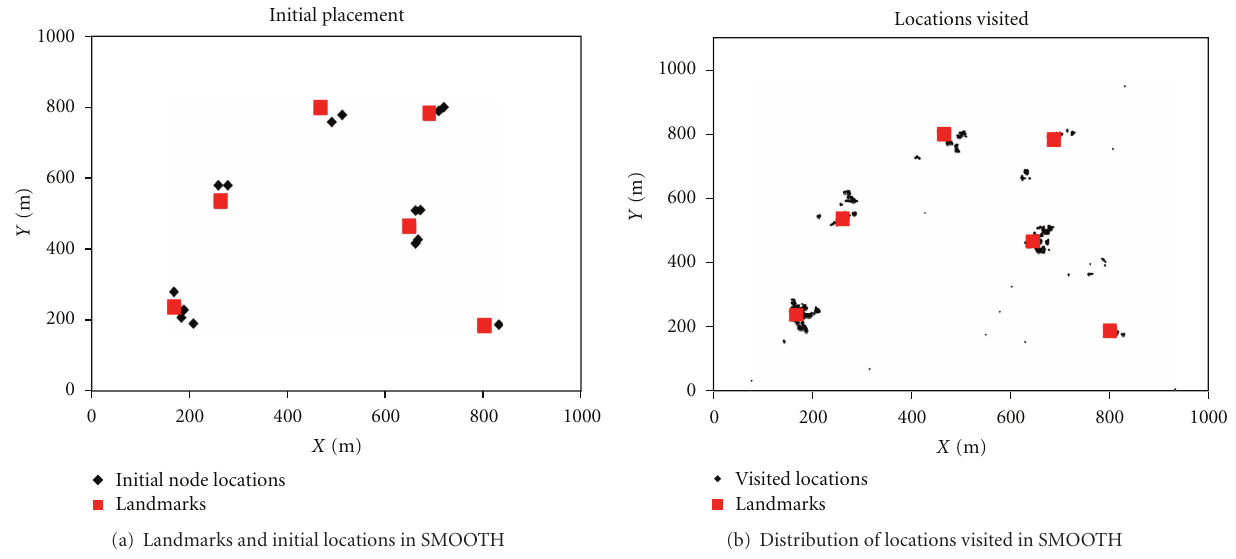
Figure 6: Example landmarks, initial locations, and distribution of locations for mobile nodes in